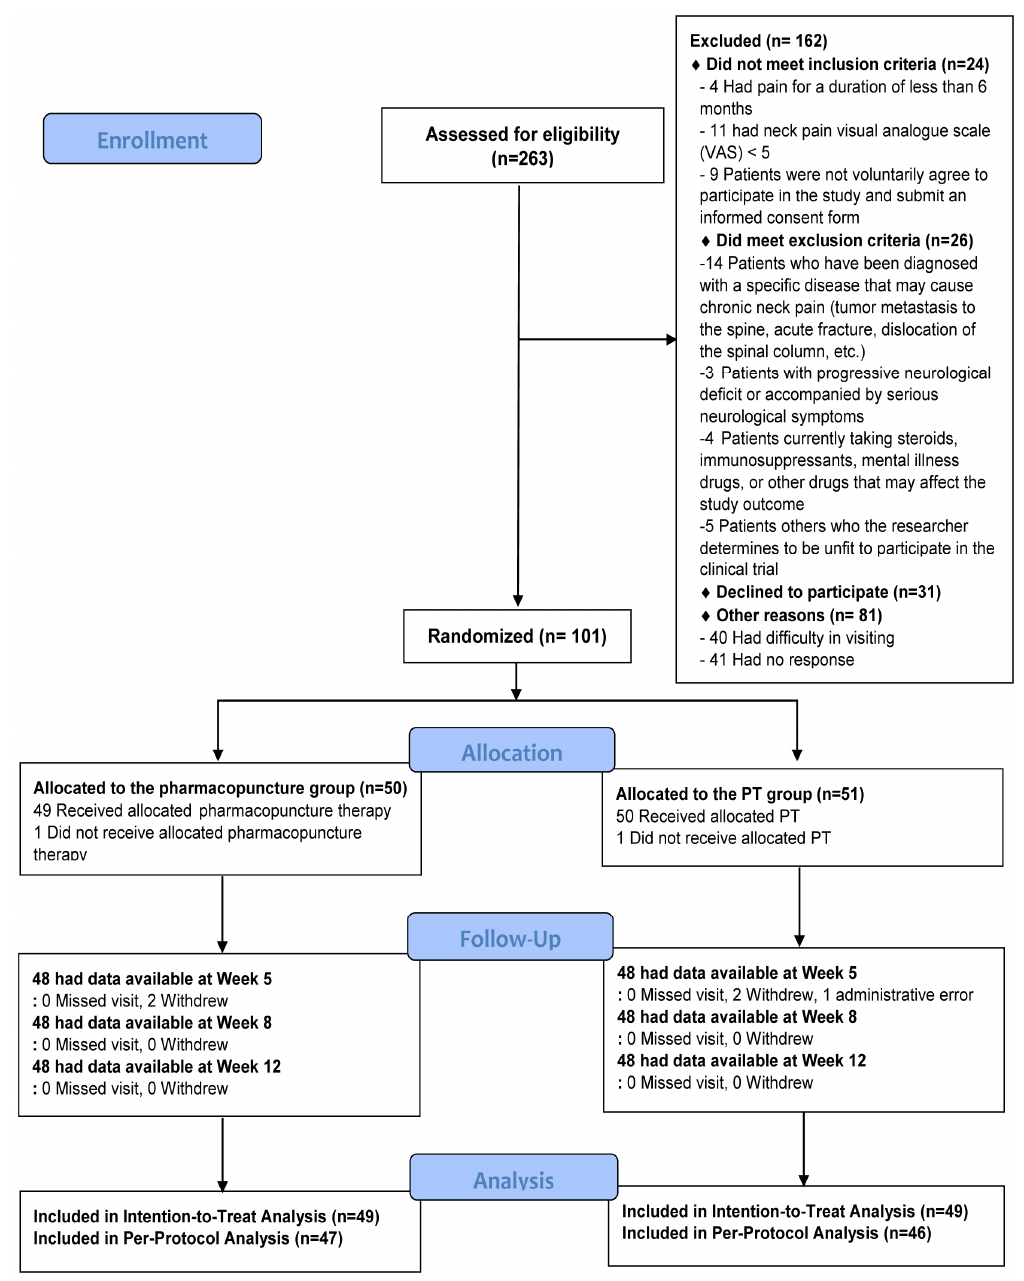
Figure 1. Flow chart of the study. VAS , visual analogue scale; PT , physical therapy.